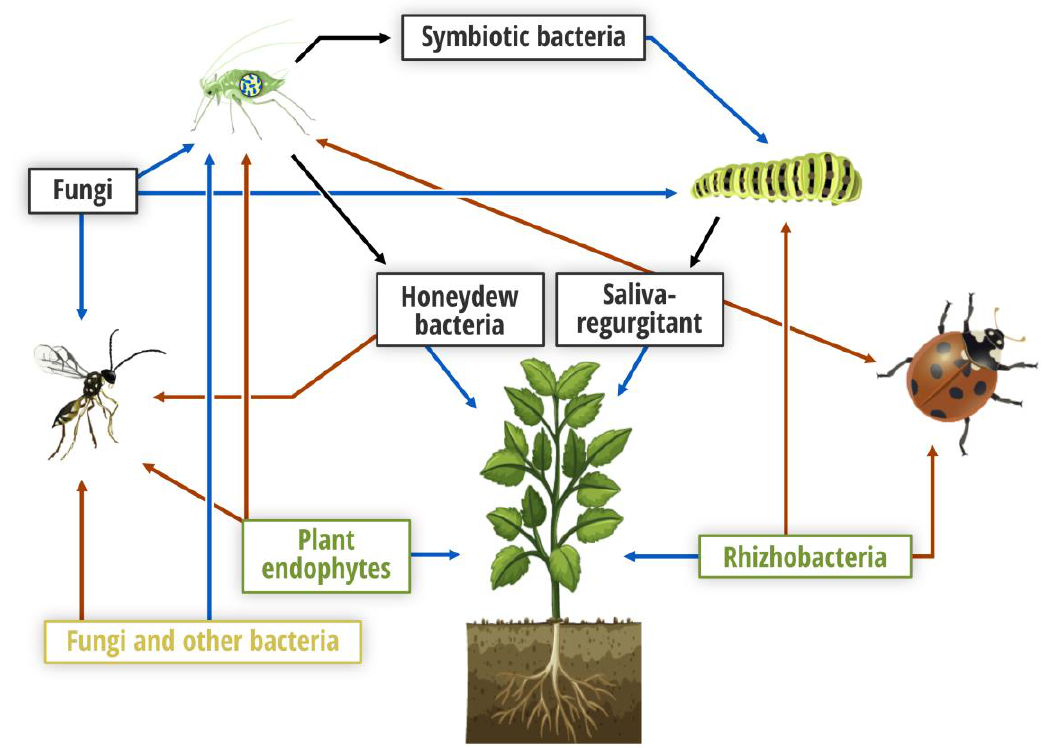
Figure 1. Illustration of multi-trophic plant–pest interactions mediated by microorganisms focusing on plants, herbivores and entomophagous arthropods. Black, green and orange colors refer to insect, plant (rhizo-, phyllo- and endospheres) and herbivore sources, respectively. Blue and red arrows indicate direct and indirect (through plants) effects on target organisms, respectively, while black arrows illustrate insect origin.